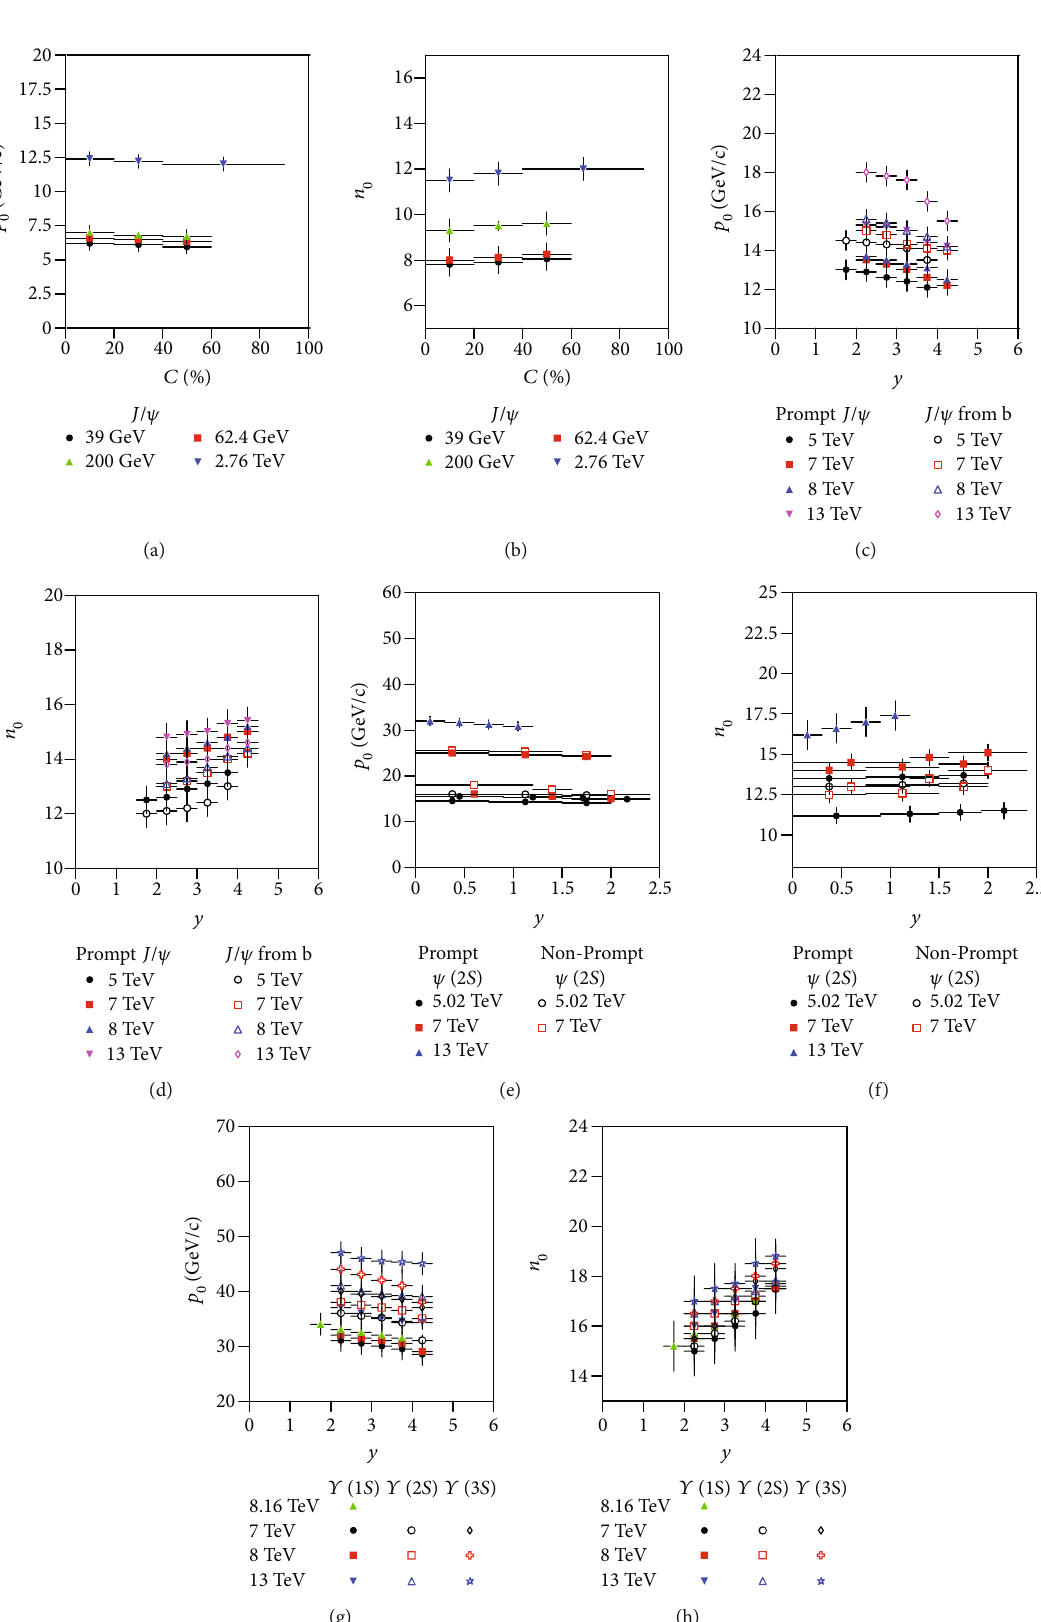
Figure 10: Same as Figure 7, but showing the dependences of (a, c, e, and g) p ψ ð 2 S Þ , and (g, h) Y ð n S, n = 1, 2, 3 Þ